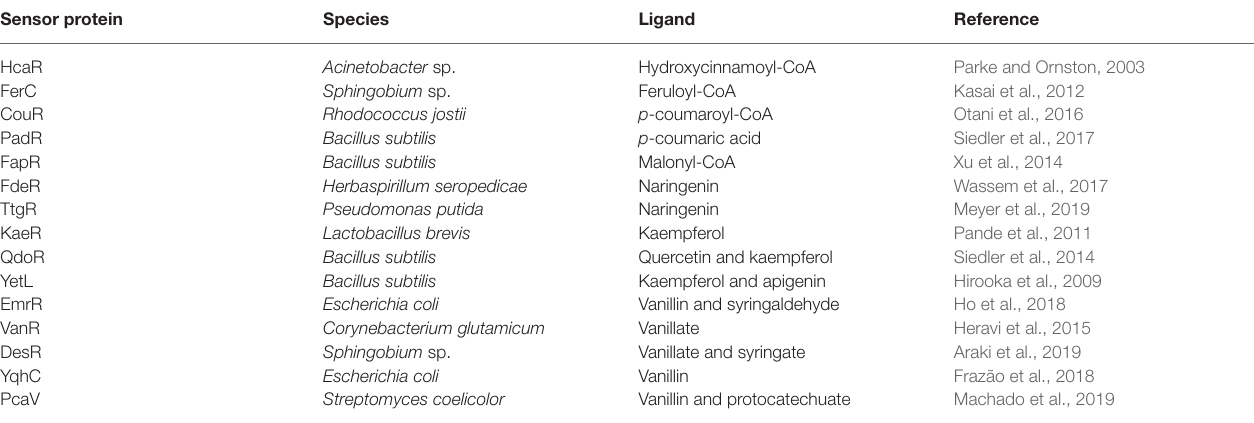
TABLE 1 | Phenylpropanoid-related bacterial sensor